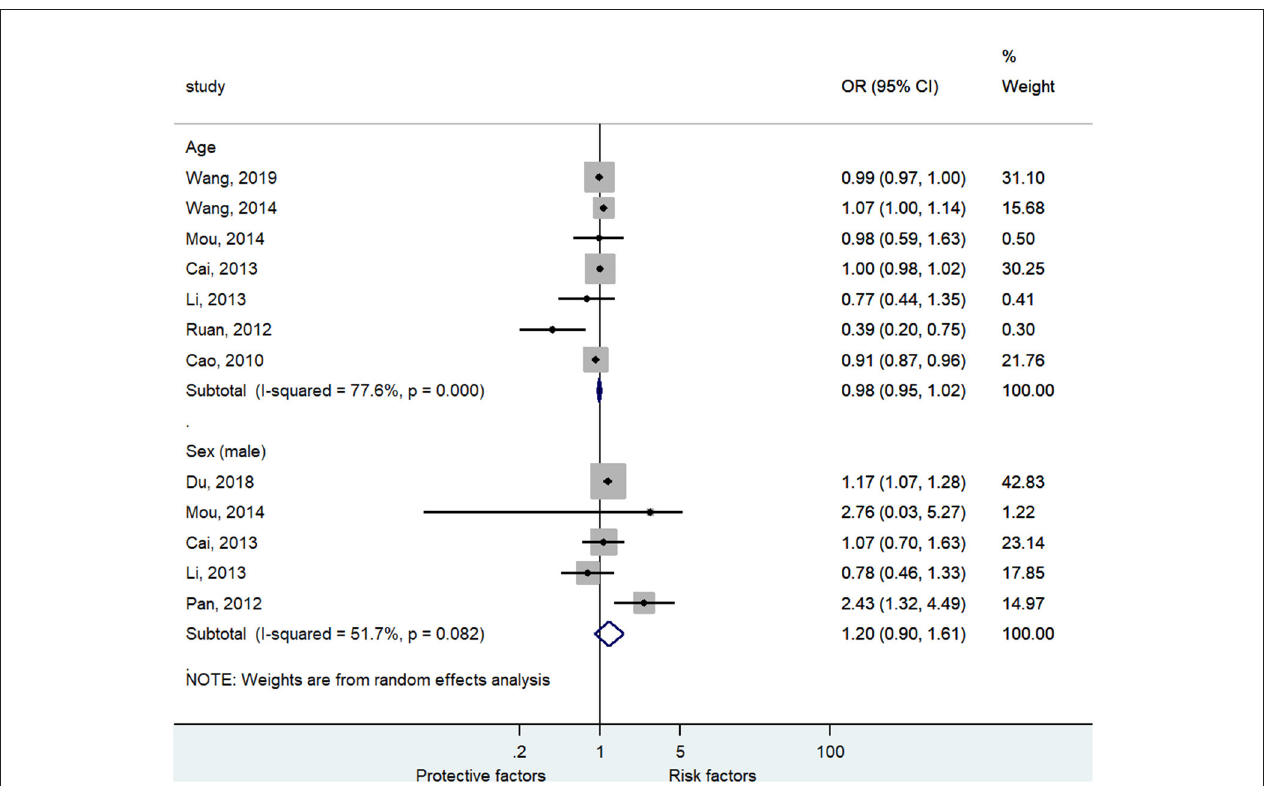
FIGURE 3 | Forest plot for the association of age and sex with severe hand foot mouth